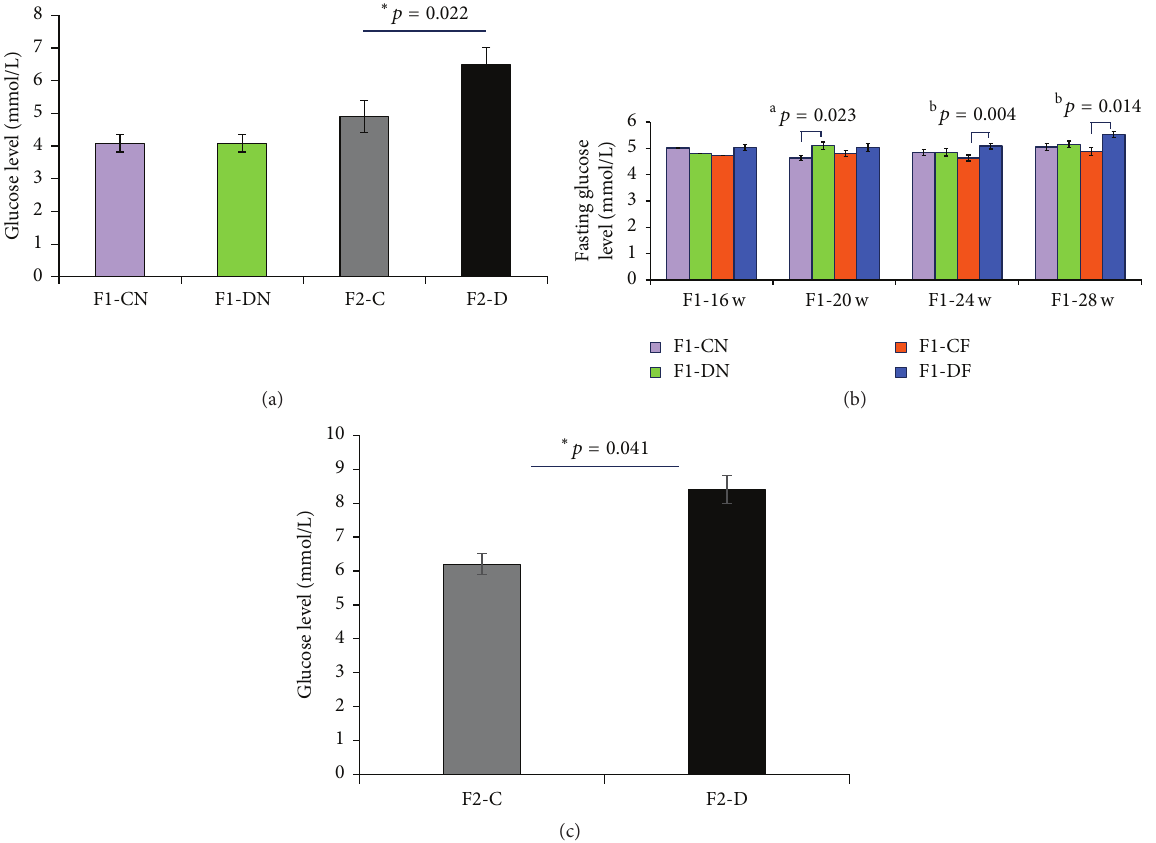
Figure 2: Glucose levels in F1 and F2 offspring. (a) The F2 offspring in the F2-D group have a higher glucose level at birth. (b) Rats in the F1-DN group have a higher fasting glucose level at 20 weeks, and rats in the F1-DF group have a higher fasting glucose level at 24 and 28 weeks than rats in the F1-CF group. (c) Rats in the F2-D group have a higher glucose level at 28 weeks. The results are means ± SEM, 𝑁 = 8 -9; a 𝑝 < 0.05 versus F1-CN; b 𝑝 < 0.05 versus F1-CF; ∗ 𝑝 < 0.05 versus F2-C.